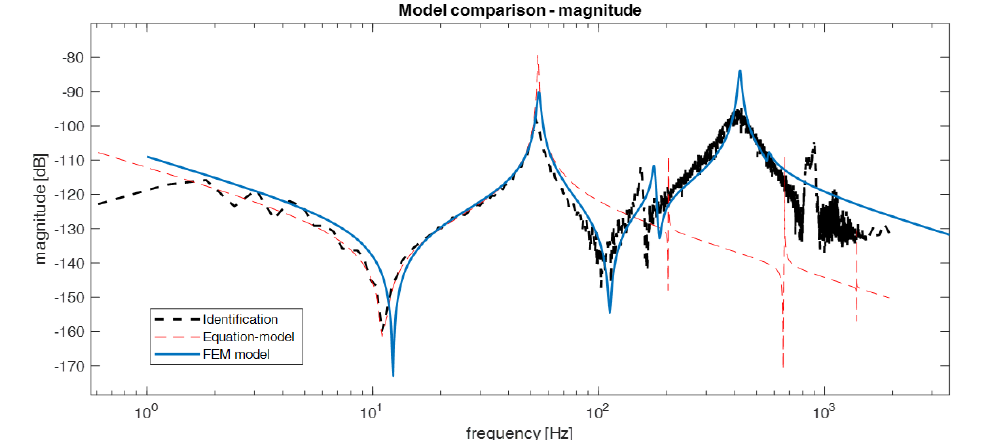
Figure 14. Comparison of physics-based models vs. experimental measurements: amplitude fre- quency response acquired from experimental identification (black), analytical equation-based model (red) and FEM model